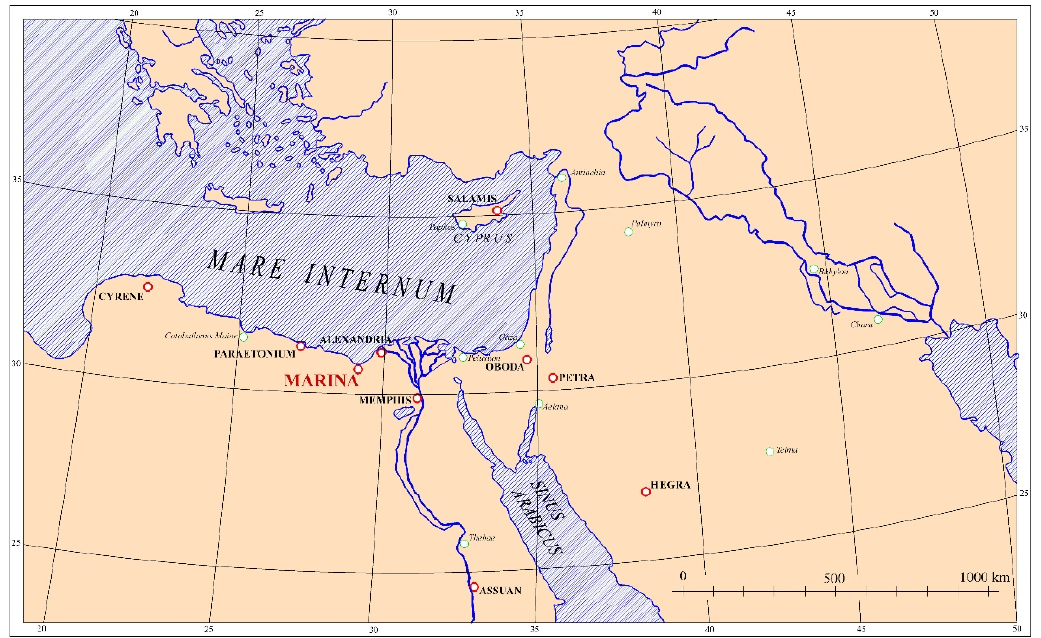
Figure 1. The position of the ancient town in Marina el-Alamein in the Eastern Mediterranean (drawing Rafa ł Czerner).